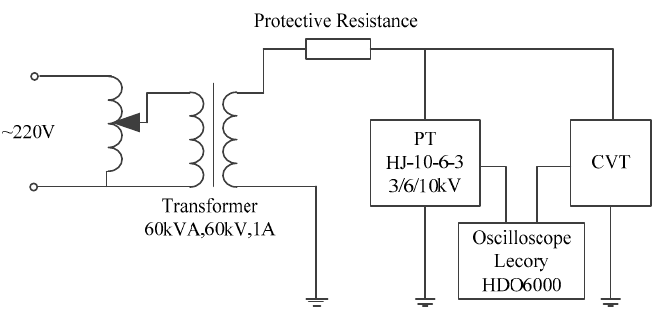
Figure 17. CVT experiment wiring diagram.